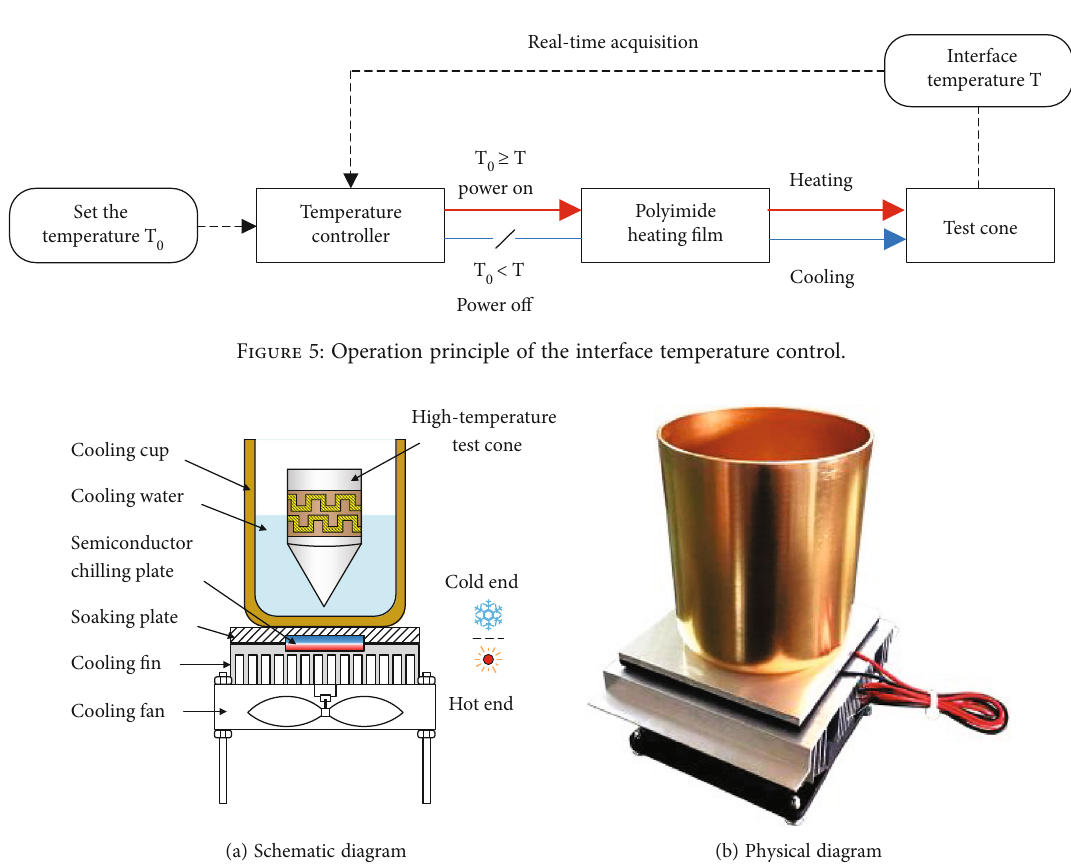
Figure 6: Semiconductor cooling device.